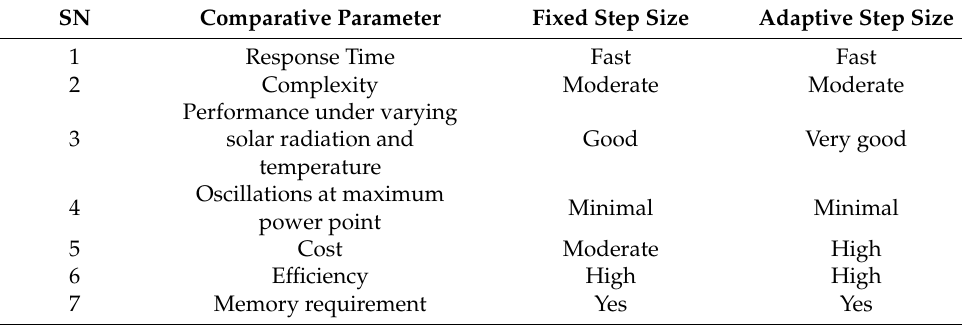
Table 3. Comparison of modified P&O